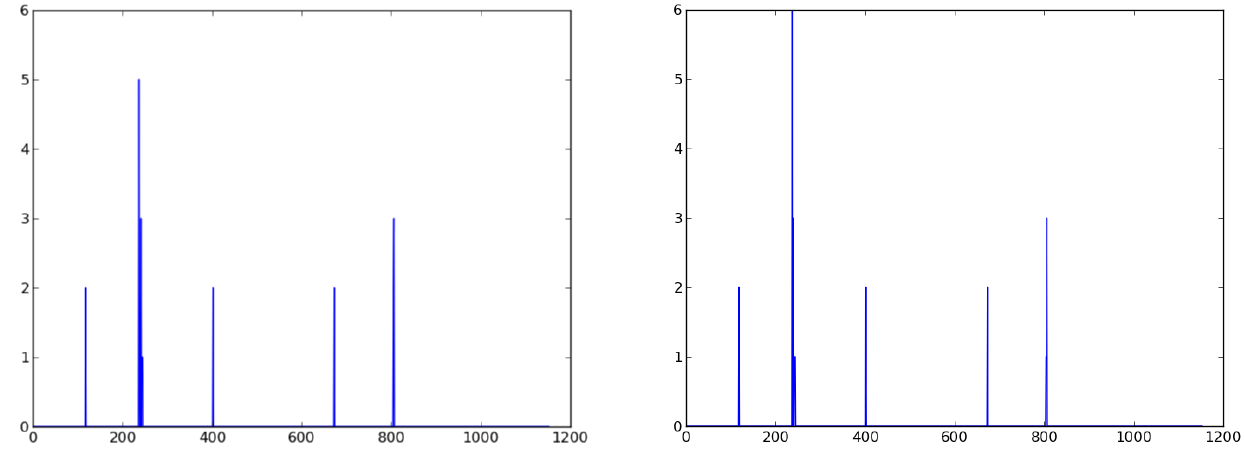
Figure 9. The histograms for the frequency distributions of the fridge sensor: the left graphic is the real dataset, whereas the right one is the simulated dataset.